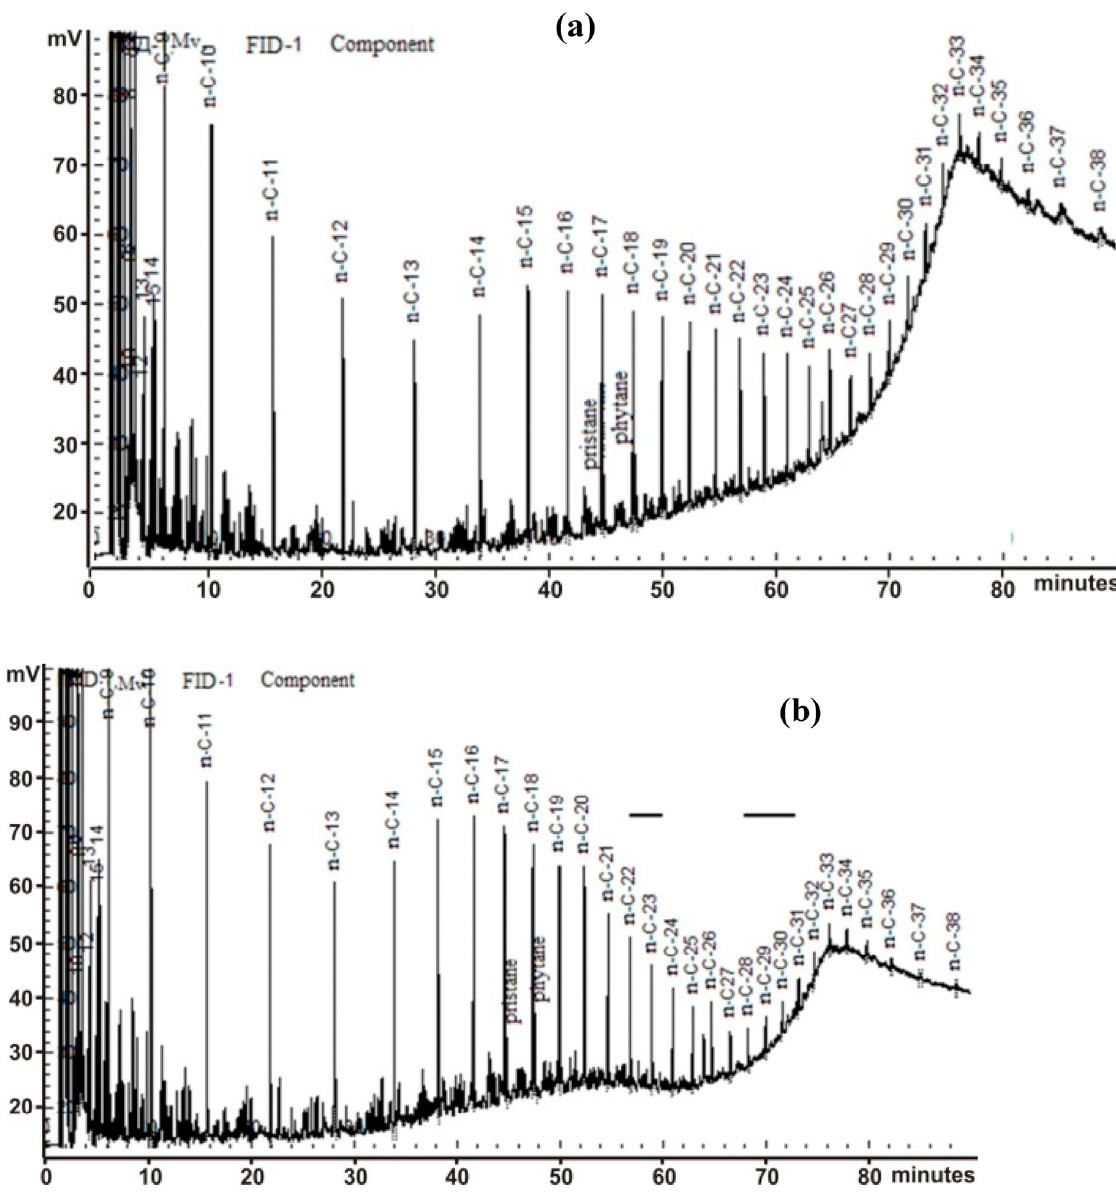
Figure 3. Chromatograms: ( a ) untreated oil and ( b ) oil after a 50 min exposure to the electromag- netic field. netic